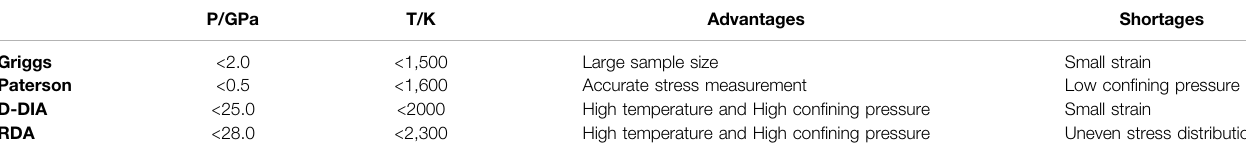
TABLE 1 | P-T ranges of some typical differential stress